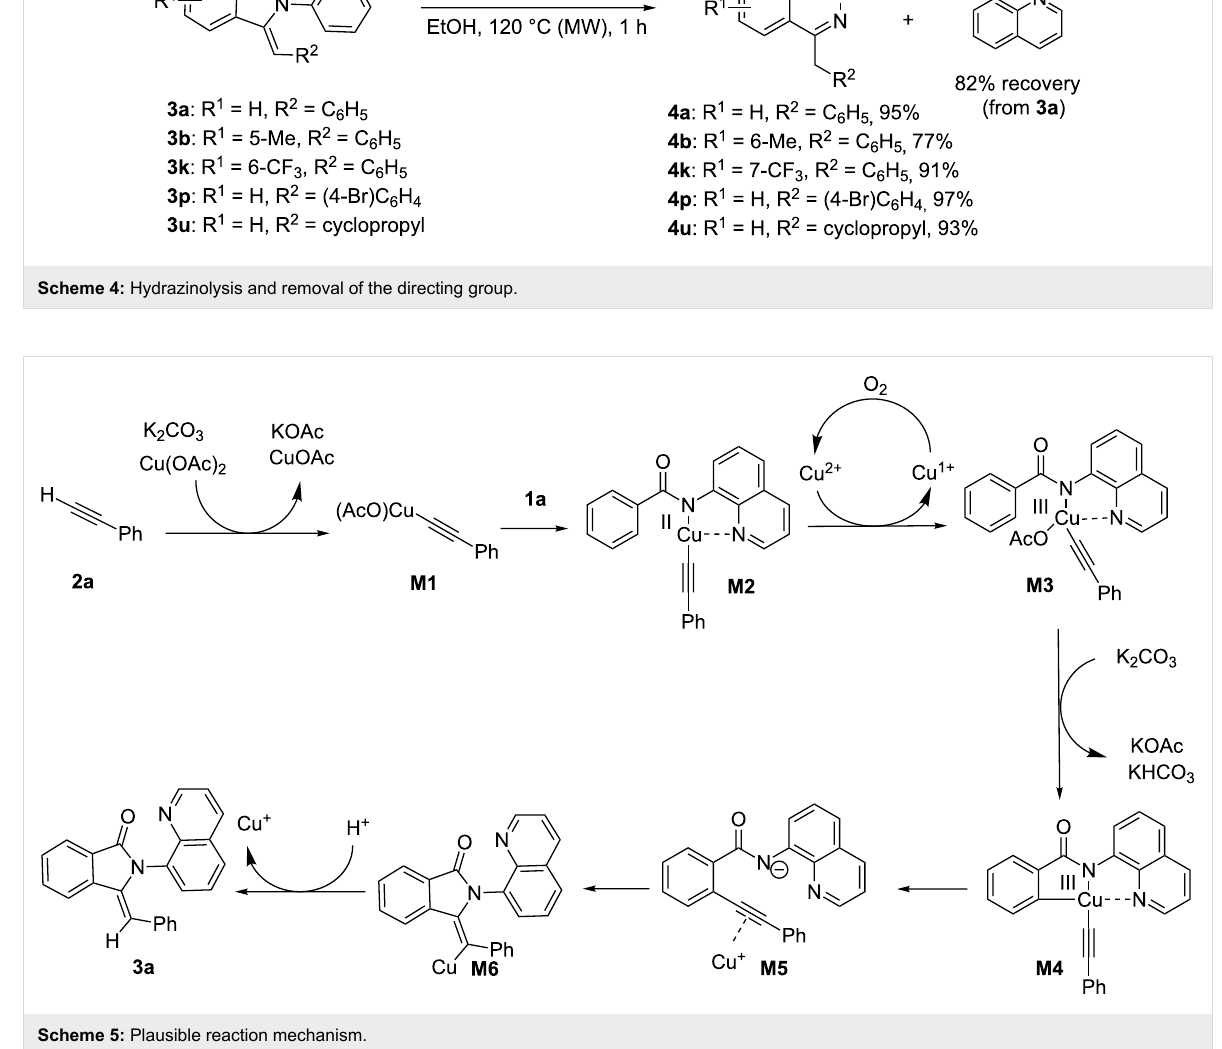
Scheme 5: Plausible reaction